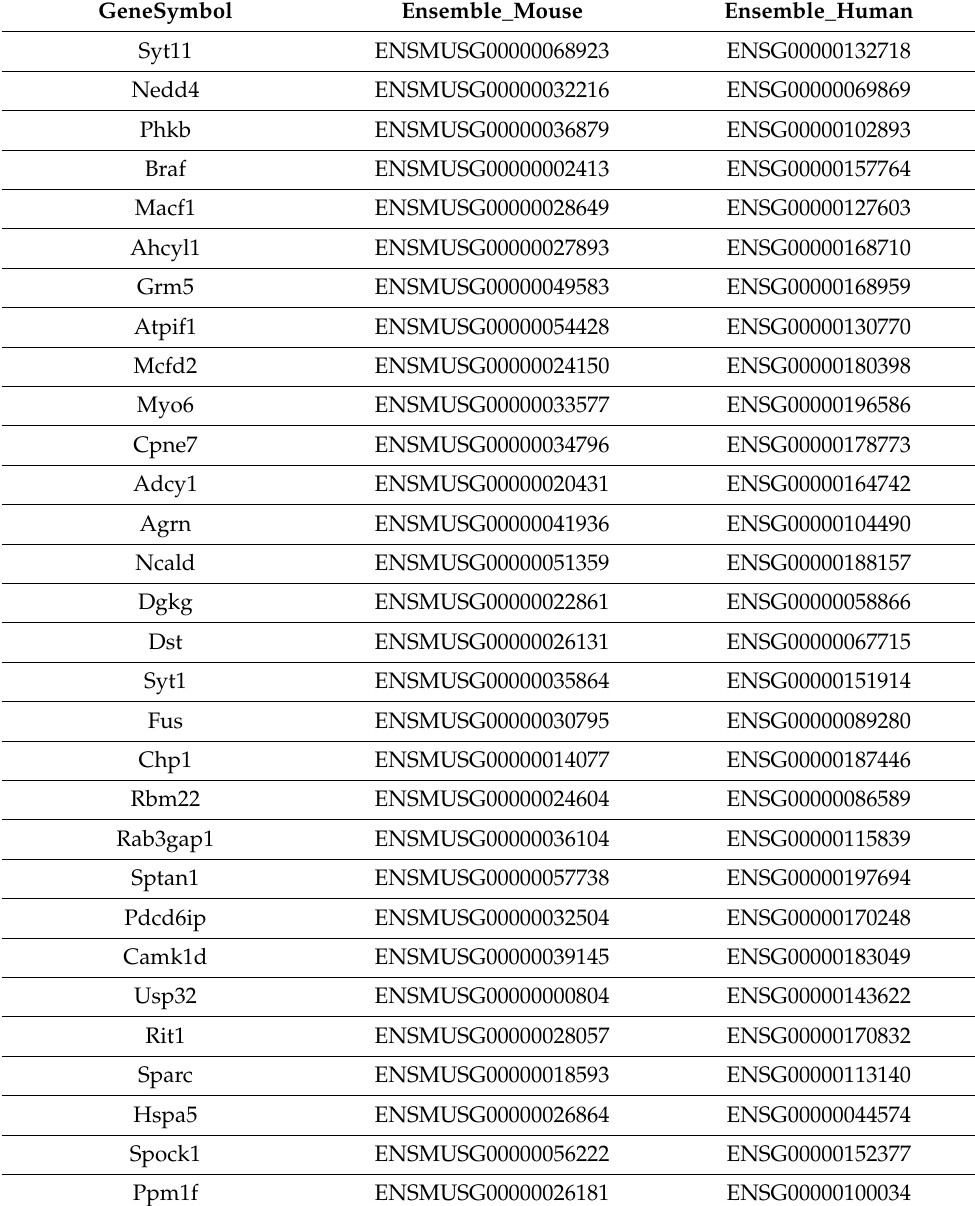
Table 3. Calcium-target signature genes identified in AS model